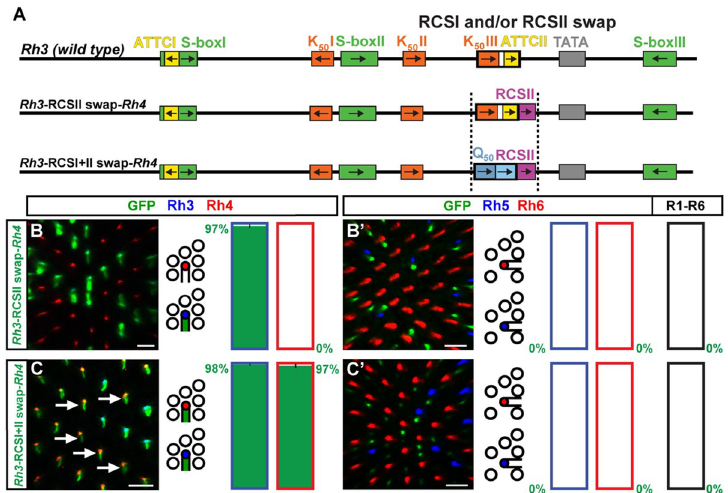
Fig 8. Incompatibility of the Rh3 promoter with the Rh4 RCSI and RCSII. (A) Wild type Rh3 promoter (top) compared with addition of the Rh4 RCSII (middle) or swap of the Rh3 RCSI with the Rh4 RCSI and Rh4 RCSII (bottom, indicated by dotted vertical lines). Note that the Rh3 and Rh4 RCSIs do not share any motifs. (B) and (C) RCSI/II swap promoter driven GFP reporter expression (green) in the R7 layer. Rh3 (blue) labels pR7s and Rh4 (red) labels yR7s. Bar graphs show GFP co-expression in the Rh3 or Rh4 subset, respectively. Green numbers indicate the mean percentage of co-expressing photoreceptors, error bar represents standard error of the mean. (B’) and (C’) RCSI/ II swap promoter driven GFP reporter expression (green) in the R8 layer. Rh5 (blue) labels pR8s and Rh6 (red) labels yR8s. Bar graphs show GFP co-expression (green) in the Rh5, Rh6, or R1-R6 subset. Green numbers indicate the mean percentage of co-expressing photoreceptors, error bar represents standard error of the mean. (B) and (B’) The addition of the Rh4 RCSII to the Rh3 promoter has no effect on subtype-specific expression of GFP in the pR7/Rh3 subset. N = 10 retinas and n = 692 R7s for (B); N = 11 retinas, n = 920 R8s and 5,520 R1-R6 PRs for (B’). (C) and (C’) The swap of the Rh3 RCSI with both the Rh4 RCSI and Rh4 RCSII causes derepression in most yR7s (arrows). N = 10 retinas and n = 721 R7s for (C); N = 9 retinas, n = 871 R8s and 5,226 R1-R6 PRs for (C’). Scale bars, 10 μ m.